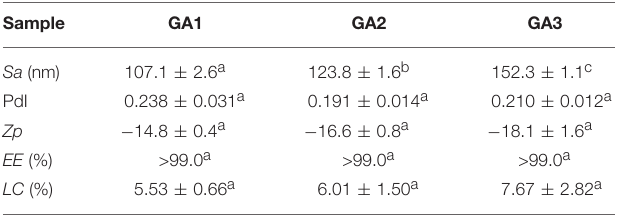
produced with galactomannan acetate with increasing acetylation degrees (GA1, GA2, and GA3).